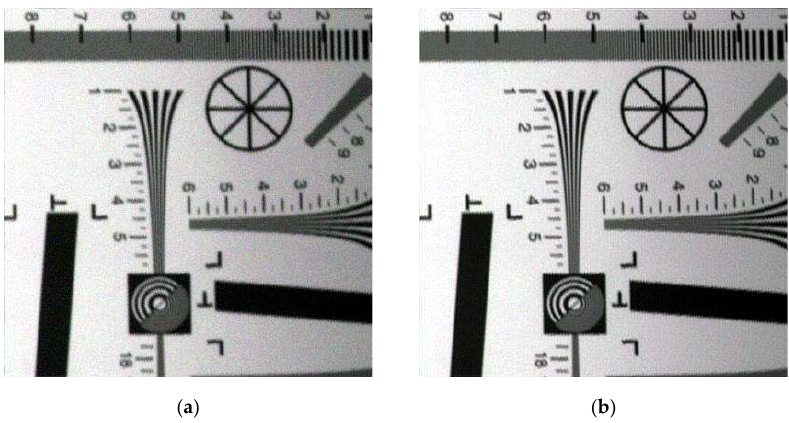
Figure 4. Flow chart of the optimal reciprocal cell combined the modulation transfer function (MTF) method.